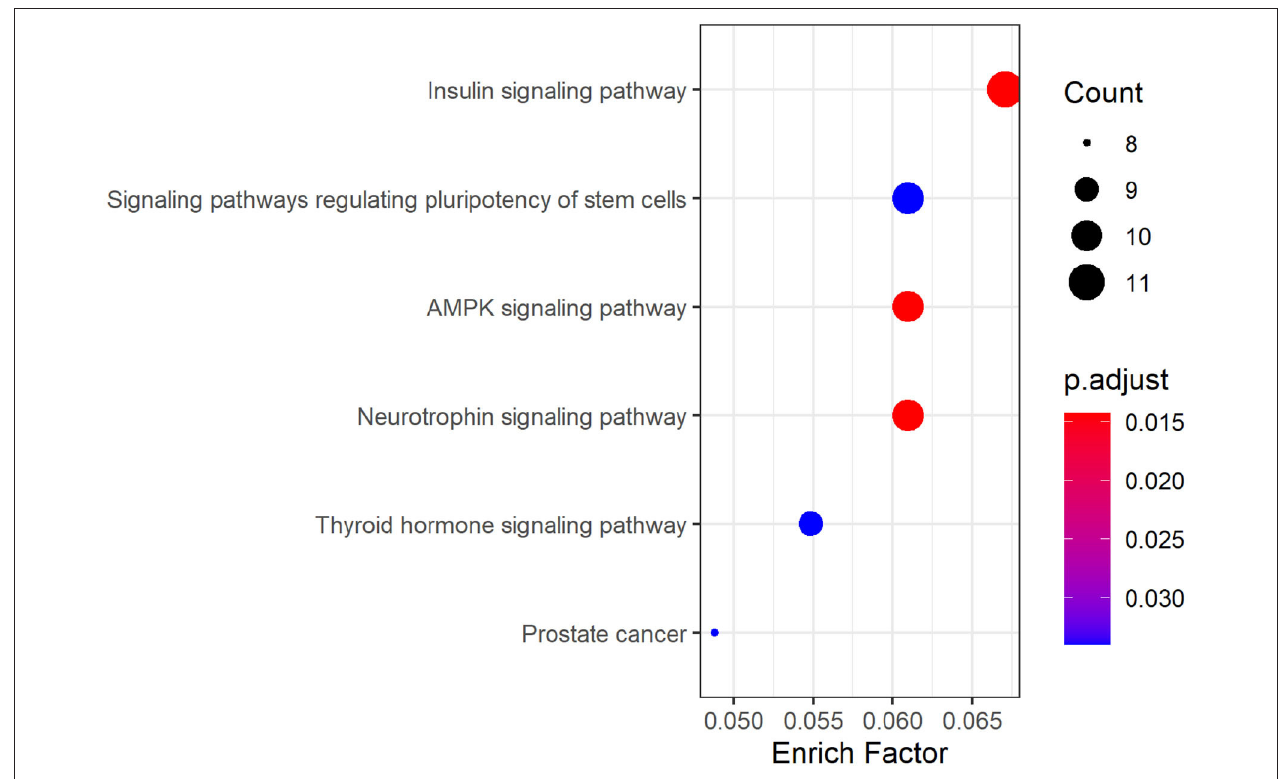
FIGURE 6 | KEGG pathway analysis dotplot of hsa_circ_0008234.